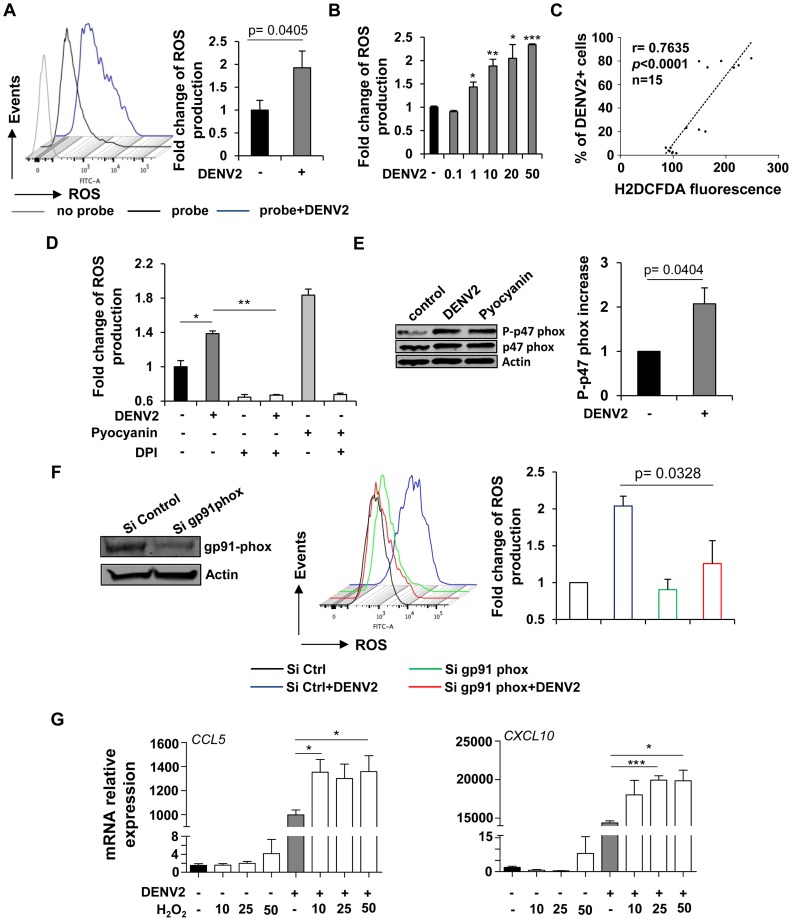
DENV-infected cells accumulate intracellular NOX-derived ROS which potentiate the immune response.(A) ROS generation in DENV-infected Mo-DC (MOI 20) was monitored by FACS using CM-H2DCFDA (1 µM) 18 h after infection. Data represent the mean ± SEM from experiments performed on four different donors. (B) Accumulation of ROS was measured by flow cytometry using CM-H2DCFDA (1 µM) 24 h after infection with increasing amount of virus. Data represent the mean ± SEM from one experiments performed on three different donors. P values were determined based on the comparison with uninfected cells (C) The correlation between the percentage of infected cells determined by intracellular staining of DENV E protein expression and the intracellular accumulation of ROS measured by DCFDA staining was calculated (n = 15; Spearman test). (D) Oxidative stress generation was detected by flow cytometry using the CM-H2DCFDA (1 µM) fluorescent probe on Mo-DC pretreated with DPI (3 µM) and infected with DENV2 (MOI 20) for 3 h or treated with the stress-inducer Pyocyanin (100 µM). Data represent the geometric mean fluorescence ± SEM from an experiment performed on two different donors. (E) Expression level of the phosphorylated NADPH-oxidase p47 subunit was assessed by immunoblotting 3 h after DENV2 infection. Histograms represent the fold change ratio of phosphorylated-p47 over total p47. Data are the means ± SEM of independent experiments performed on three different donors. P value was determined based on the comparison with uninfected cells. (F) Mo-DC were transfected with control or gp91 phox siRNA and 48 h later were infected with DENV2 (MOI 20) for 18 h. ROS accumulation was measured by FACS using the CM-H2DCFDA fluorescent probe. Data are the means ± SEM of three independent experiments performed on different donors. P value was determined based on the comparison with cells infected with DENV and transfected with the control siRNA sequences (G) Mo-DC were treated with increasing concentrations of hydrogen peroxide (10–50 µM) in the presence or absence of DENV2 (MOI 20). CCL5 and CXCL10 mRNA expression levels were monitored by qPCR 24 h following treatment and infection. Data represent the means ± SEM from one experiment performed on three individual donors. Experiment has been repeated twice. P values were determined based on the comparison with DENV2-infected cells.